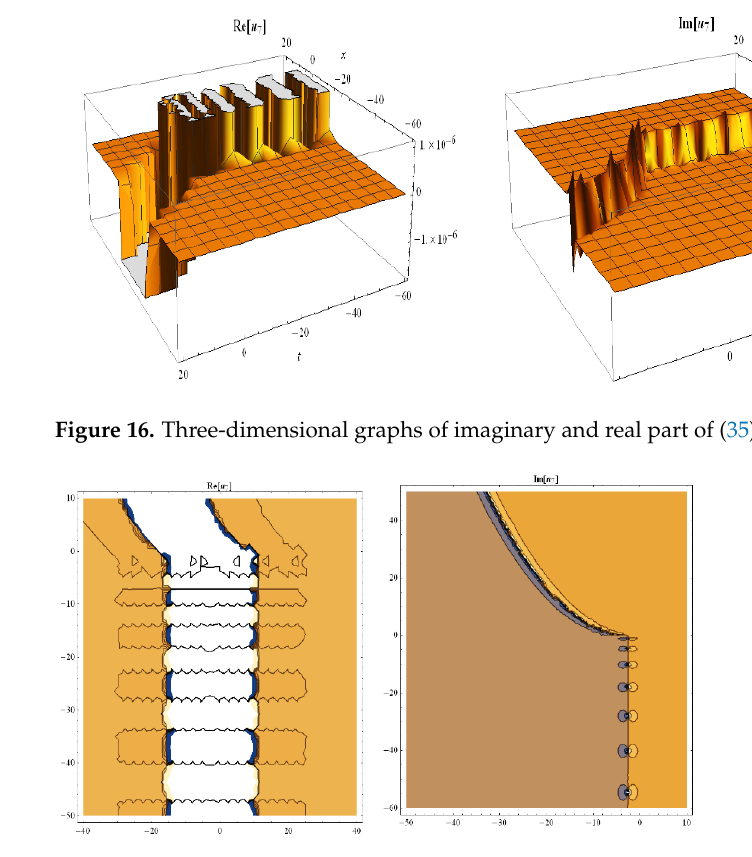
Figure 17. Contour graphs of imaginary and real part of (35).